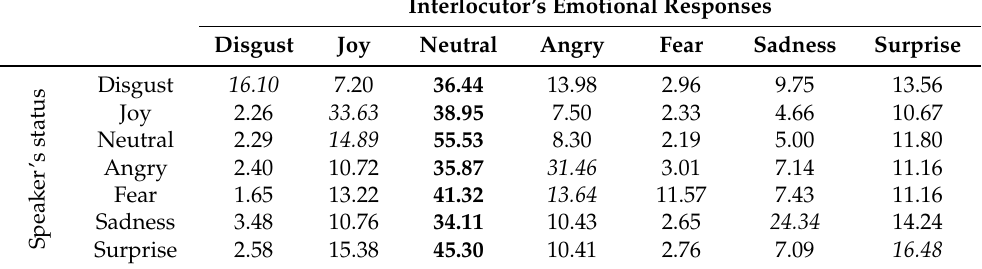
Table 2. The percentage(%) of emotional responses between speaker and interlocutor in human– human interaction (MELD). Bold numbers represent the highest value; italicized numbers represent the second highest